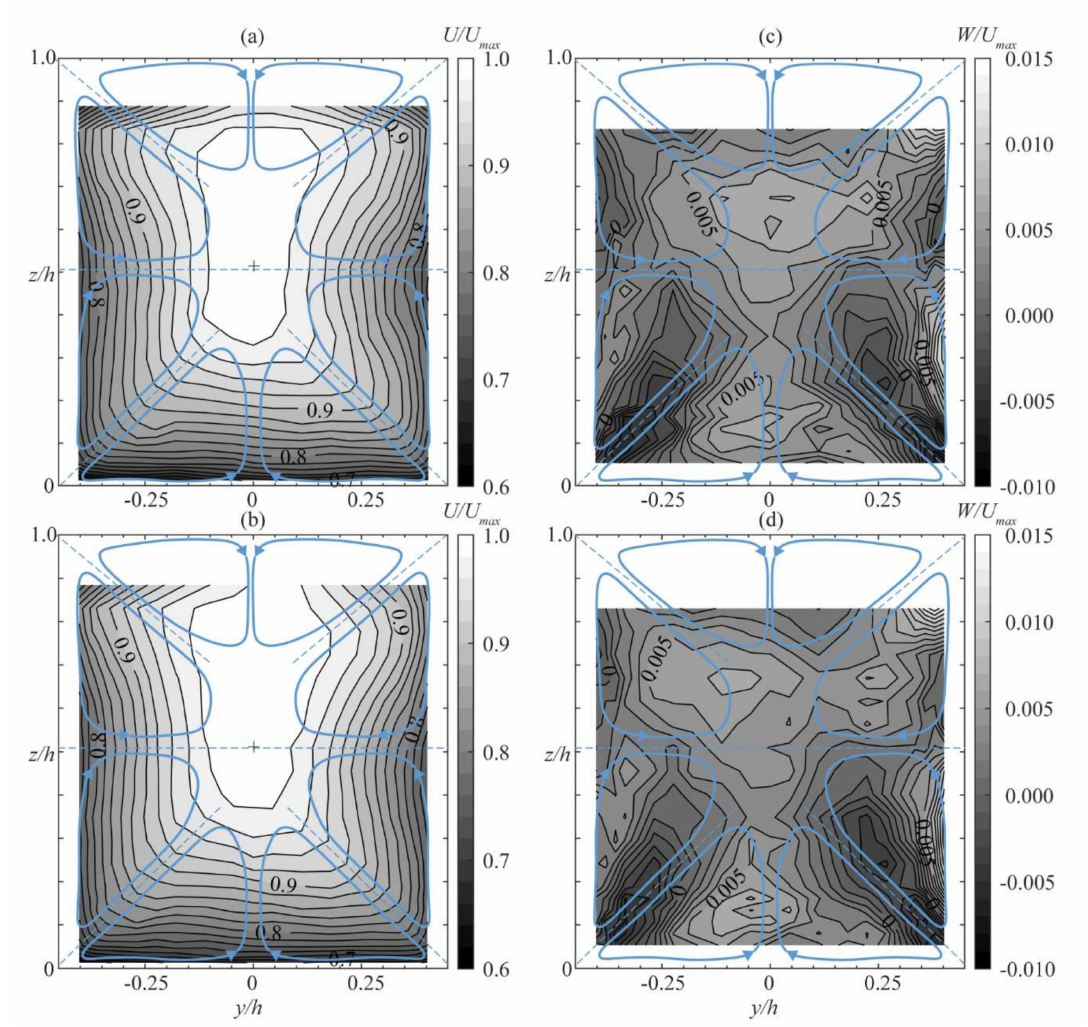
Figure 4. Contour plots of mean normalized flow velocities in ( a , b ) streamwise direction, ( c , d ) vertical direction for TA7 and